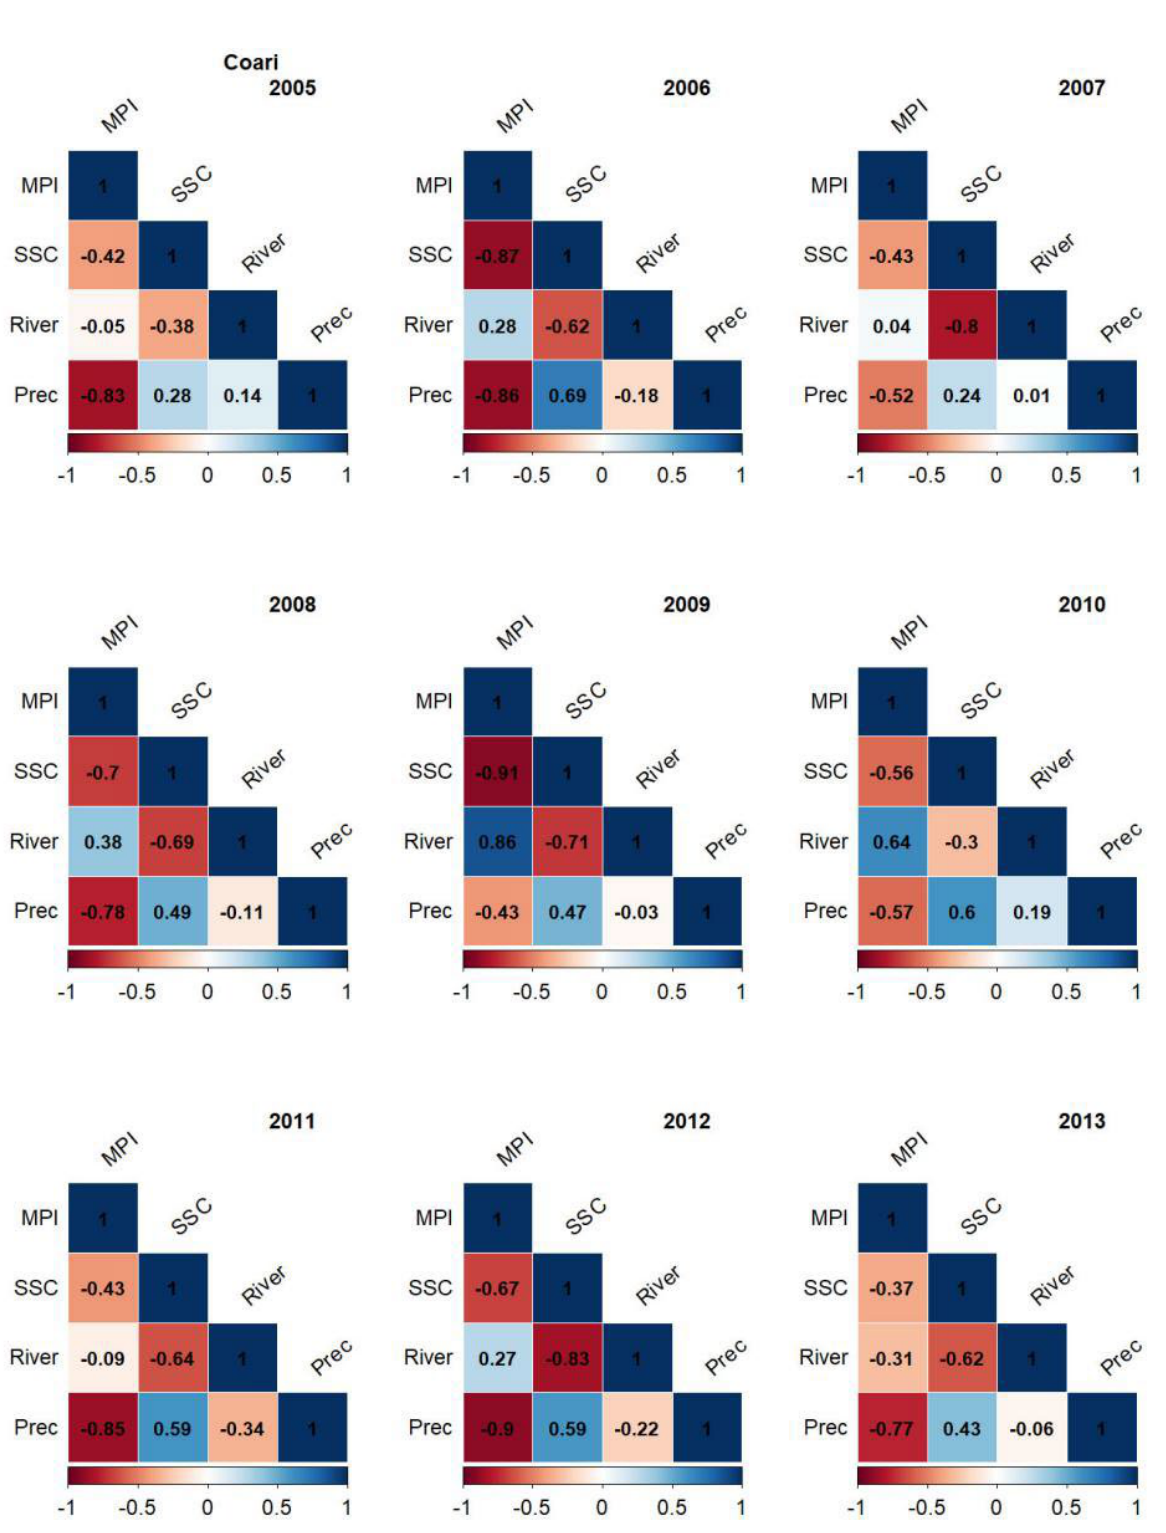
Figure 5. For the municipality of Coari, the relationship between monthly malaria parasite index (MPI), of suspended sediment concentration in rivers (SSC), river level (River), and precipitation (Prec), during the period 2005–2013.